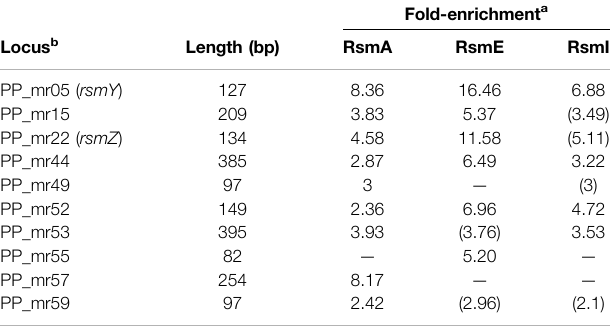
Fold-enrichment a